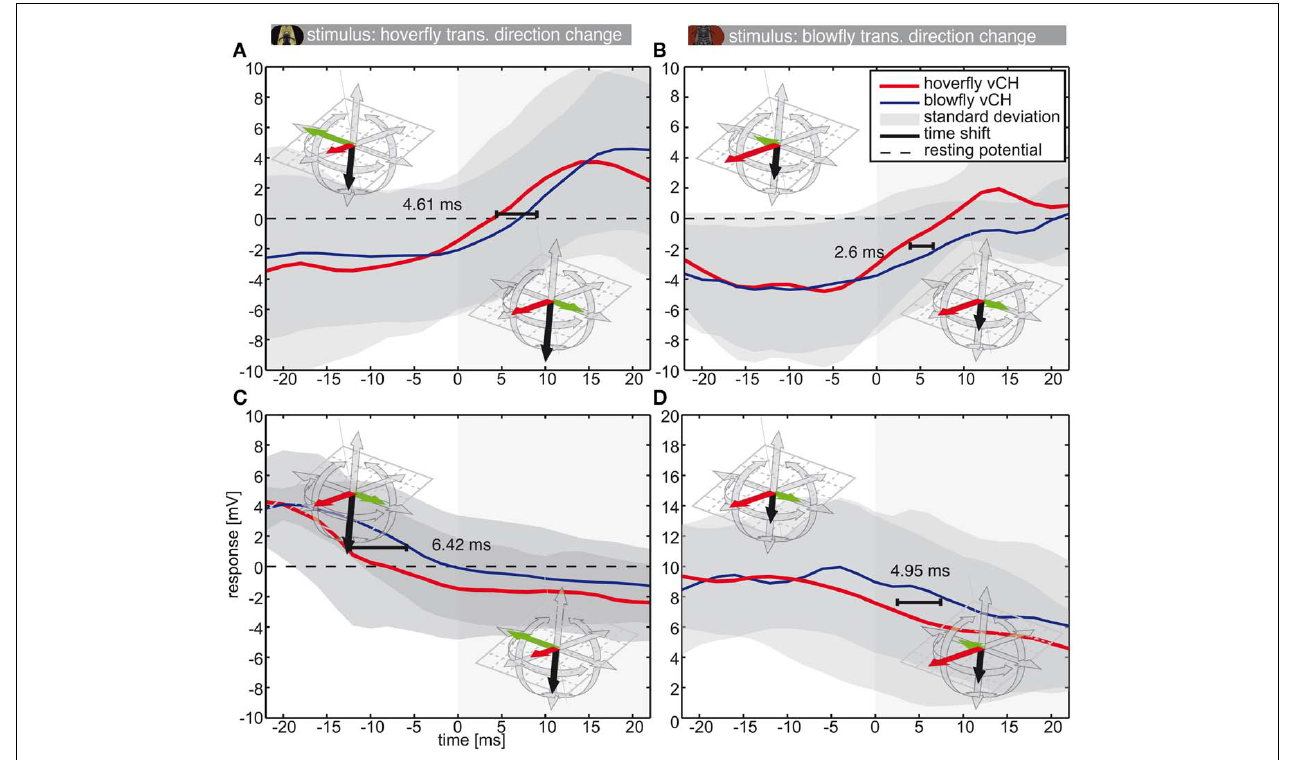
vice versa (C,D) (see insets). At 0ms the direction switches. Responses in (A,C) were elicited by Eristalis flights.The stimuli in (B,D) were from Calliphora .The time shift denotes the time difference between reaching the half-maximal response in Eristalis and Calliphora vCH, respectively. Resting potential is marked by the dashed black line. Note the differently scaled y -axis in (D)